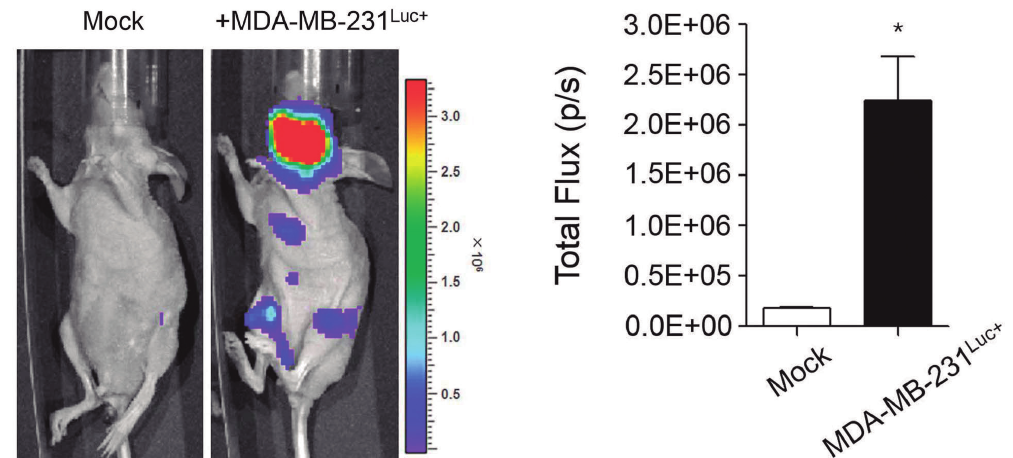
Figure 1- Mouse model for metastatic breast cancer to the mandible. The growth and part of the metastatic spread (left) was detected by bioluminescence imaging after the injection of cancer cells. The formed metastases were quantified by measuring total photon flux per second (right). Data are expressed as the mean±standard error (SEM). * P <0.001 versus Mock